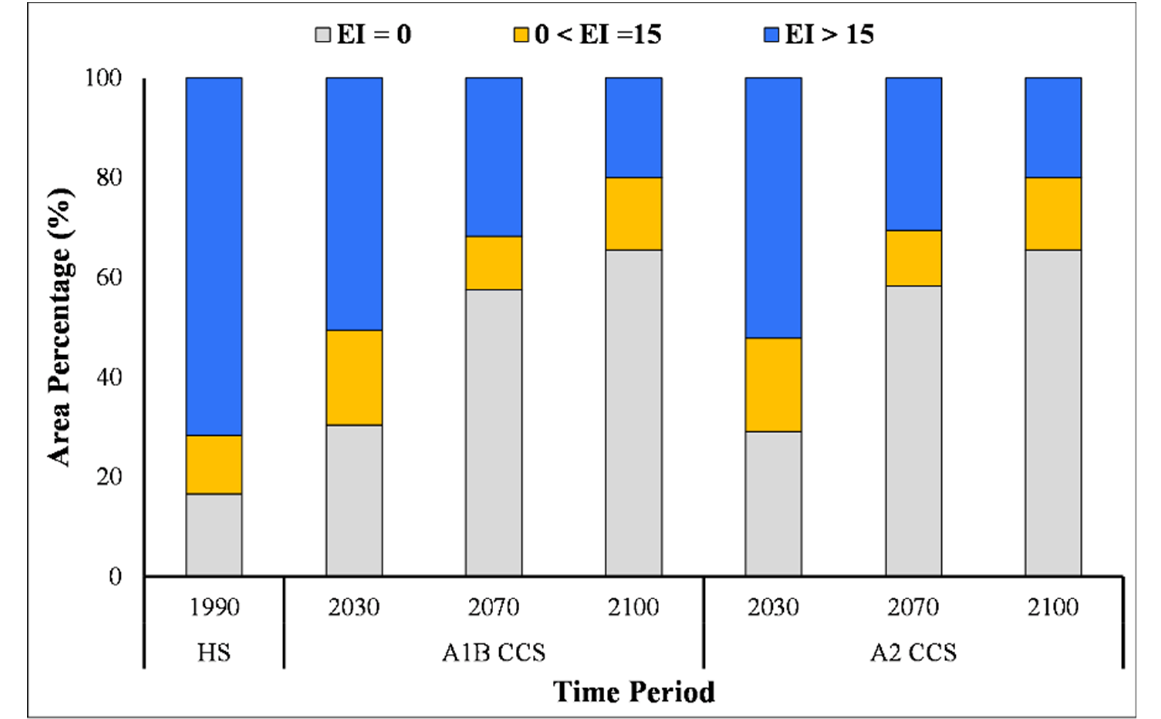
Figure 3. The global land area percentage of Aelosthes sarta within the three ecoclimatic index ranges under the historic and future climatic conditions under A1B and A2 climate change scenarios. Optimum habitat (EI > 15); suitable habitat (0 < EI = 15); and unsuitable habitat (EI = 0). HS = historic; CSS = climate change scenario.